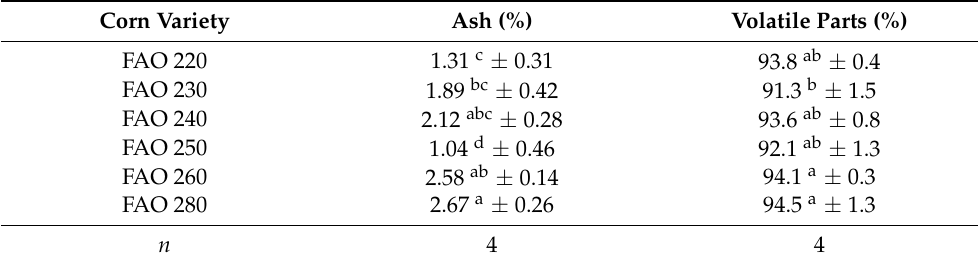
Table 3. Ash and volatile matter